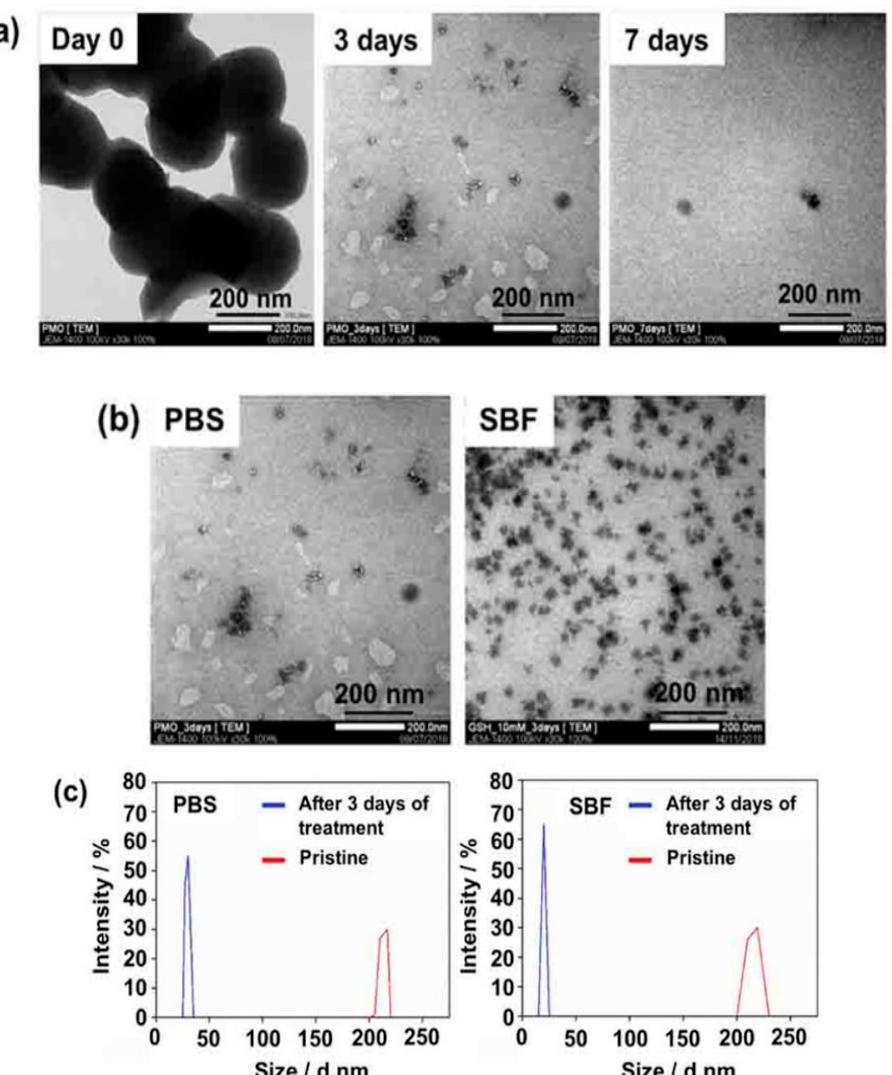
Figure 2. In vitro degradation of BPMOs: ( a ) TEM of degraded BPMO after incubating in PBS with glutathione (GSH) (10 mM) for various times. ( b ) TEM of BPMO after incubating with GSH (10 mM) in PBS or simulated body fluid (SBF) for 3 days. ( c ) Dynamic light scattering (DLS) measurements confirmed the average size of pristine BPMOs and degraded fragments after 3 days of treatment. Adapted from [39], Wiley Publications,